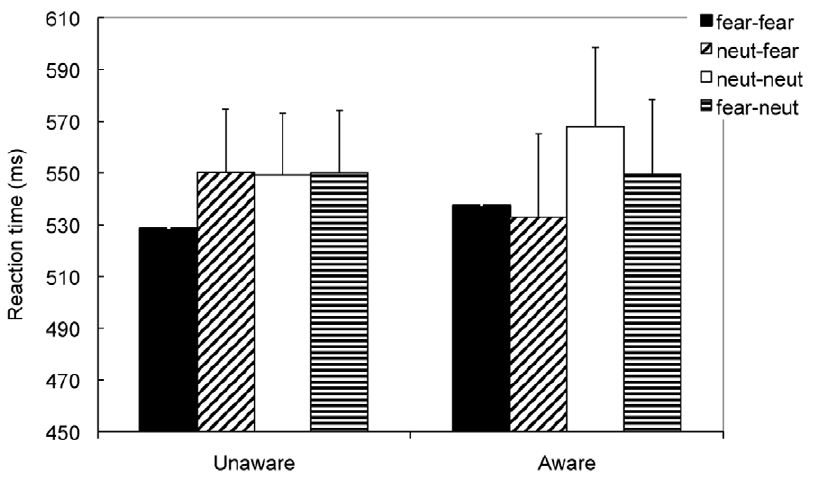
Figure 2. Results of Experiment 1. For the unaware participants, the fear–fear faces were judged more quickly than the neutral–fear faces, but the neutral–neutral faces were judged with RTs comparable to the fear–neutral faces.